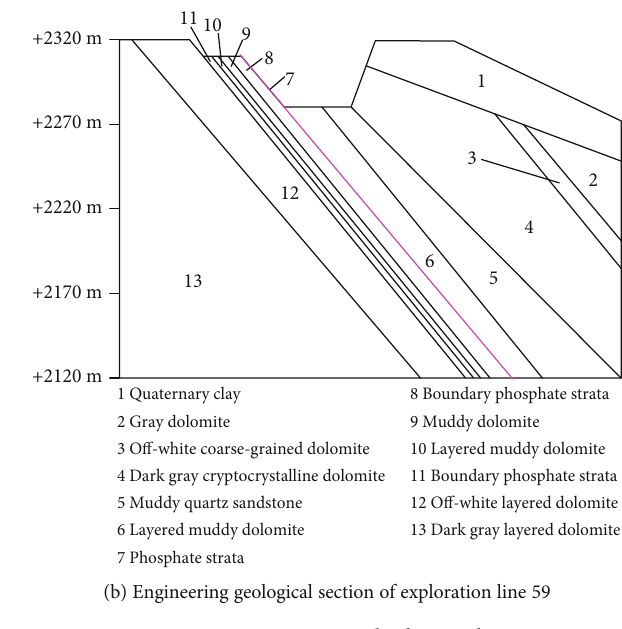
Figure 1: Engineering